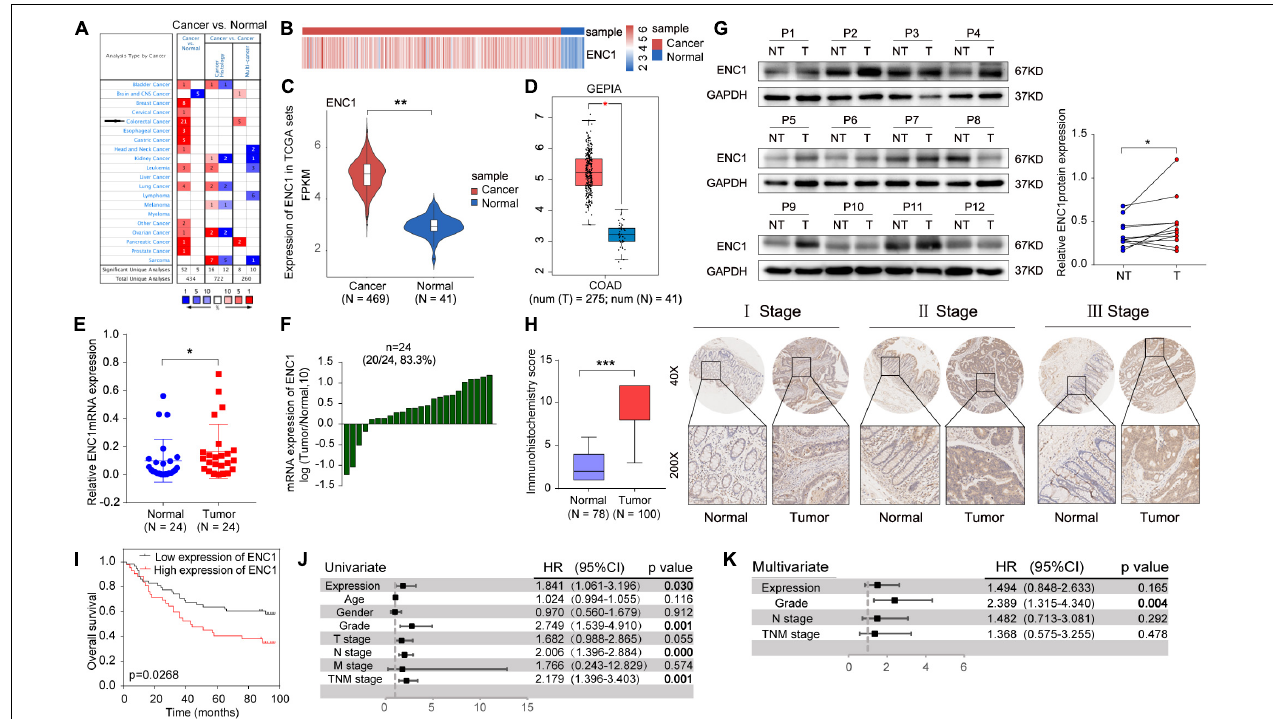
FIGURE 1 | ENC1 expression is often upregulated in CRC and associated with poor clinical outcomes. (A) The ENC1 mRNA expression levels in CRC and other cancers from the Oncomine cohort. The threshold was selected with the following parameters: p-value of 1E-4, fold change of 2, and gene rank of top 10%. (B,C) Heat map and Violin plot presented the upregulated expression of ENC1 between CRC ( n = 469) and normal colon tissues ( n = 41) by bioinformatics analysis from TCGA. Unpaired t -test, ** P < 0.01. (D) ENC1 expression was overexpressed in CRC ( n = 275) compared with normal colon tissues ( n = 41) by box plot in the GEPIA database. * P < 0.05. (E) The ENC1 mRNA expression in 24 paired CRC patients quantified from qRT-PCR. Wilcoxon matched-pair test, * P < 0.05. (F) Log10-fold change was used to show the differential mRNA expression of ENC1 between CRC and normal tissues. (G) The ENC1 protein expression was detected by Western blotting in 12 pairs of CRC tissues (T) and adjacent normal tissues (NT). The scatter plot revealed the relevant density of ENC1 protein expression. (H) IHC analysis of ENC1 expression in CRC TMAs. Representative stage images were shown (upper: magnification × 40, scale bar = 500 µ m; lower: magnification × 200, scale bar = 100 µ m). Box plot described the IHC score of ENC1 in 100 CRC tissues (IHC score: 9.17 ± 2.719) and 78 matched peritumoral tissues (IHC score: 2.397 ± 1.59). Mean ± SD, unpaired t -test, *** P < 0.001. (I) Kaplan–Meier’s overall survival curve showed that the patients with a higher expression level of ENC1 have a shorter survival period. (J) Univariate and (K) multivariate Cox proportional hazard analyses were conducted to evaluate the HR of ENC1 for overall survival in